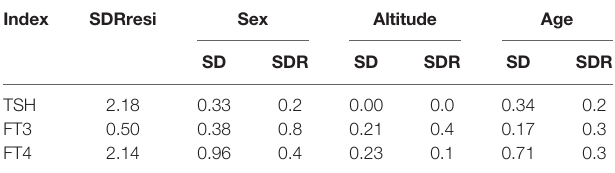
TABLE 3 | Results of variance component model for thyroid-associated